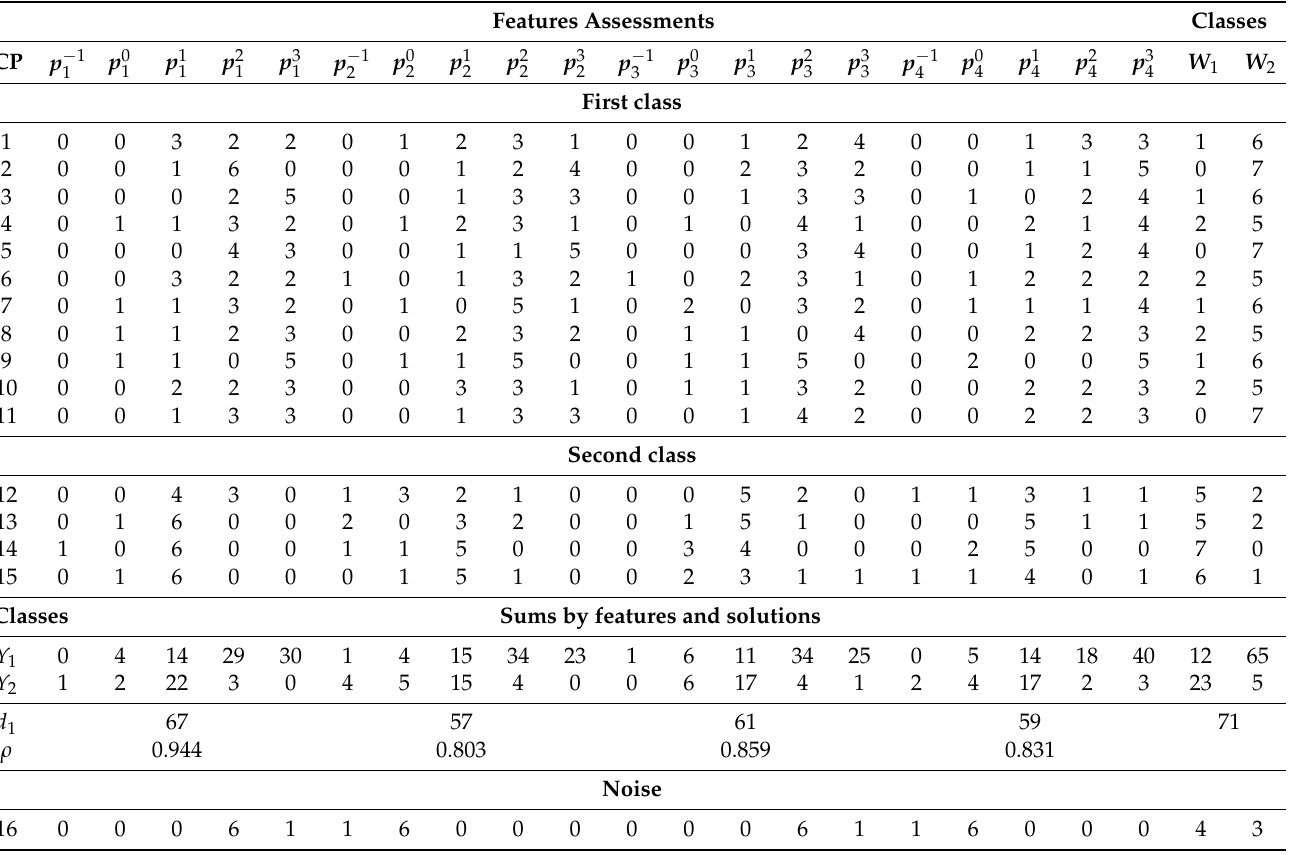
Table 2. Division of competitive projects into classes ‘Accept the CP for implementation’ and ‘Reject the